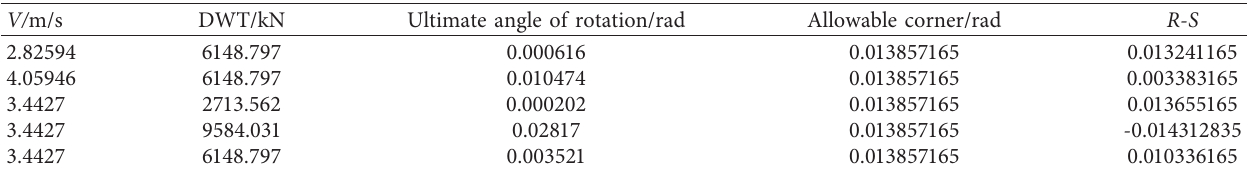
Table 8: iteration (at bridge